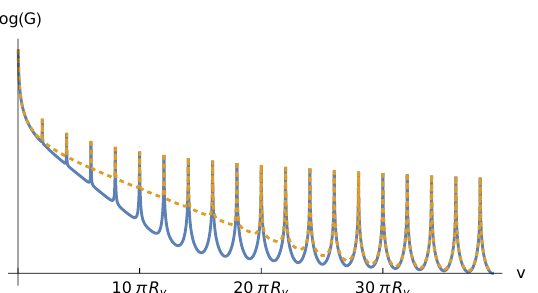
= π/ 20 for the solid R y